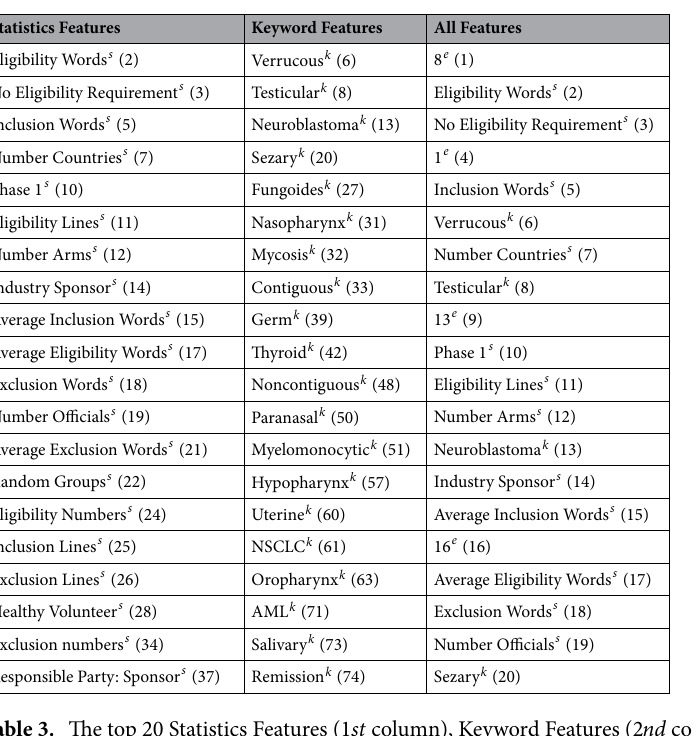
Table 3. The top 20 Statistics Features (1 st column), Keyword Features (2 nd column), and overall ranked features (3 rd column) using Dowdall Aggregation. The superscripts ( s , k , e ) denote feature types (statistics features, keyword features, or word embedding features, respectively). The number in the parenthesis denotes the aggregated ranking of the feature, with (1) being the best ranking. Table 1 in the Supplement further lists the top 40 features.